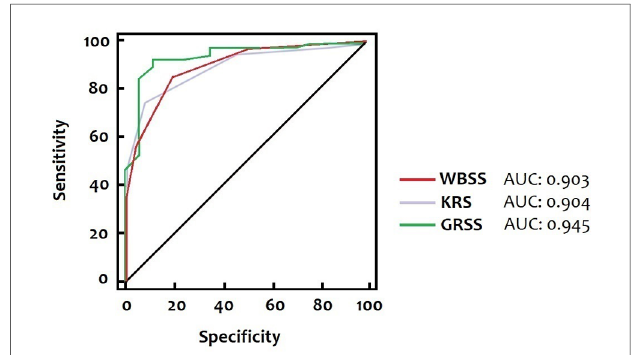
FIGURE 1 Receiver-operating characteristic curves of three different scores (WBSS, KRS, GRSS). The AUC for the WBSS, the KRS, and the GRSS is 0.903, 0.904, and 0.945, respectively, corresponding to cut-off values of >3,> 3, and>3.8.